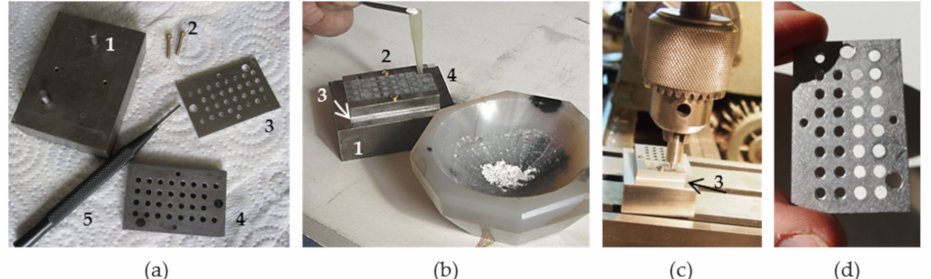
Figure 1. The sequence of the sample preparation: ( a ) pieces to be used; a small platform (1), two screws (2) to adjust the perforated aluminum plate (3) in which the samples will be inserted and placed under the perforated plate (4) and a manual piston (5) to help introduce the powder sample in each hole. ( b ) After grinding, 3 mg of powder sample is introduced in each hole; ( c ) each sample must be highly compressed; ( d ) example of an aluminum holder plate with half of the prepared